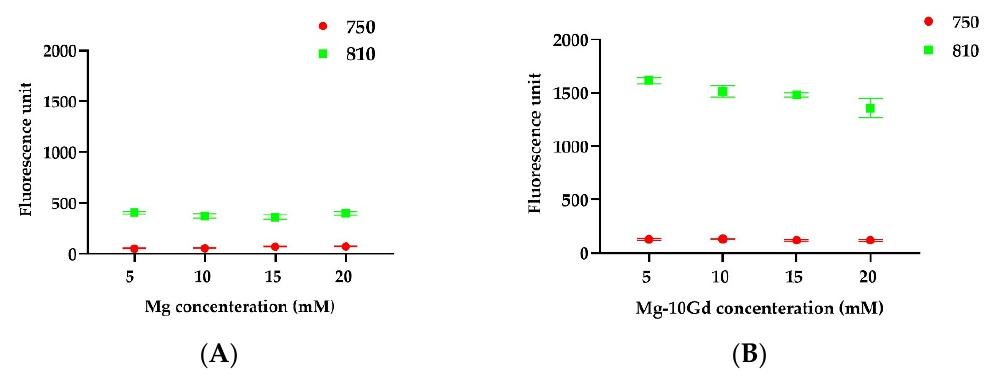
Figure 2. The in vitro assay to study the effect of Mg ions on the liposomal ICG fluorescence was studied. The ICG fluorescence was measured (Ex: 750 nm / Em: 810) from the liposomes loaded with ICG and coupled with α -MSH peptide ( ● = 750 nm, ■ = 810 nm). ( A ) The liposome dilution (1:25; v / v ) was treated with varying concentrations of Mg (5 mM, 10 mM, 15 mM, and 20 mM). ( B ) The liposome dilution (1:25; v / v ) was treated with varying concentrations of Mg-10Gd (dilution of ex- tract 5 mM, 10 mM, 15 mM, and 20